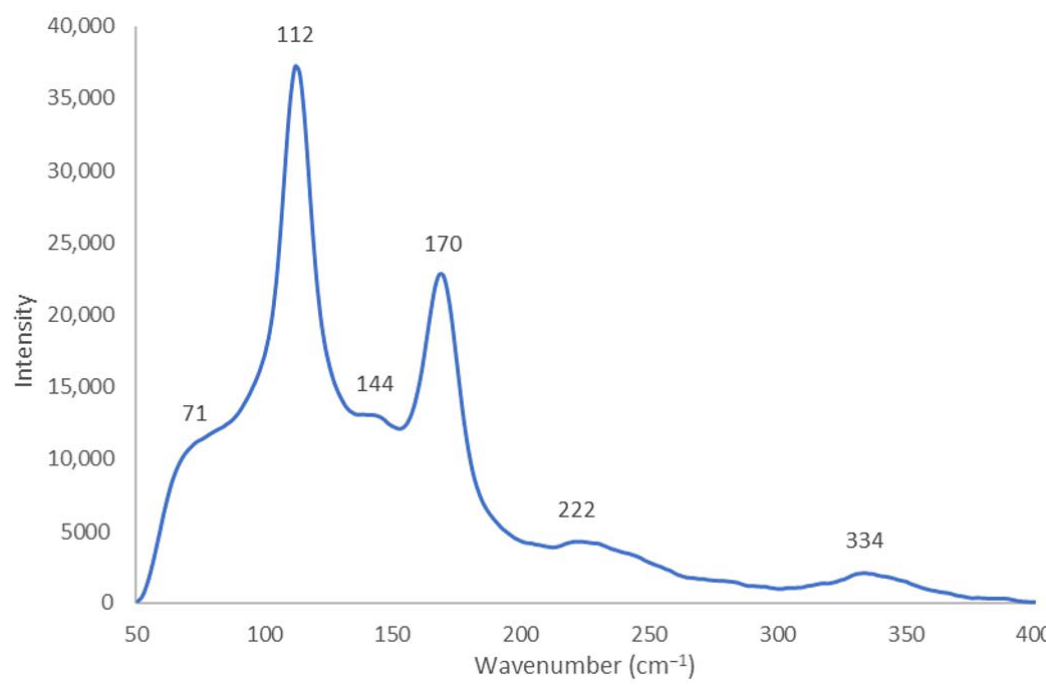
Figure 2. The Raman spectroscopic analysis of [Cu(12 ‐ crown ‐ 4) 2 ]I 5 . The compound [Cu(H 2 O) 6 (12 ‐ crown ‐ 4) 5 ]I 6 x 2I 2 revealed the Raman shift of the crown